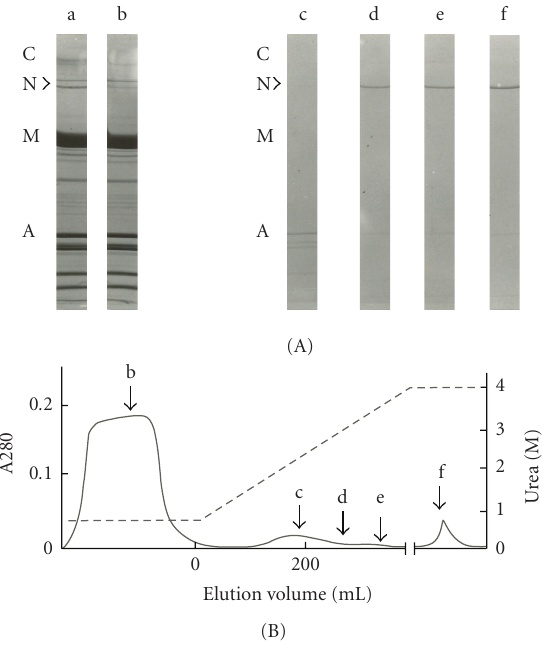
Figure 3: Modified purification of nebulin from rabbit skeletal muscle by DEAE-Toyopearl column chromatography. A muscle extract in 0.18 M KPO 4 (pH 7.0), 0.1mM MgCl 2 , 0.1mM EGTA, and 1M urea was loaded to DEAE-Toyopearl column and linear urea gradient up to 4M was applied. (A) SDS-PAGE patterns of each fraction of (B), (B) Elution pattern. a, applied sample; b, flow- through fraction; c–e, eluted fraction; f, overnight fraction with 4M